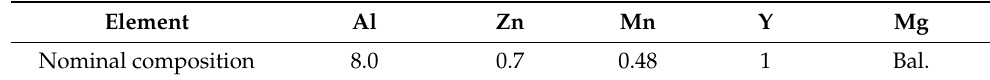
Table 1. Chemical composition of AZ80-1Y. Element